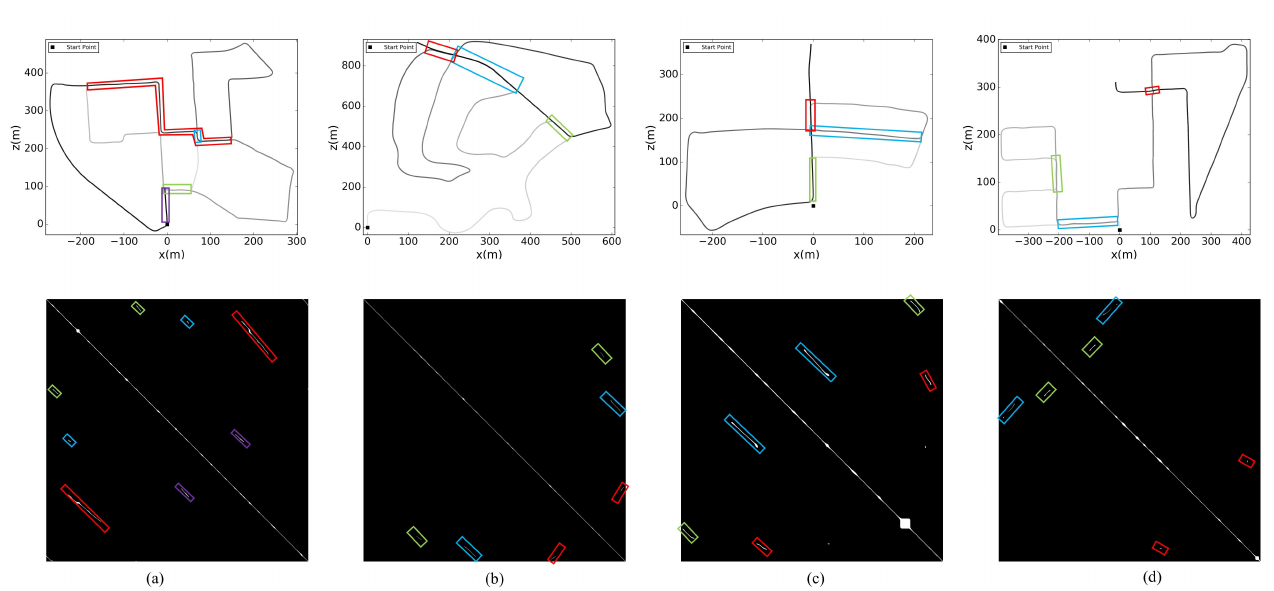
Figure 24. The ground truth loop closure segments of partial KITTI sequences. ( a ) KITTI sequence 00 with 4 loop closure segments. ( b ) KITTI sequence 02 with 3 loop closure segments. ( c ) KITTI sequence 05 with 3 loop closure segments. ( d ) KITTI sequence 08 with 3 loop closure segments. The top row is the GPS trajectory plotted from light to dark with time going, and the bottom row is the corresponding ground truth affinity matrices. We use the same color to indicate the correspondence between trajectory and affinity